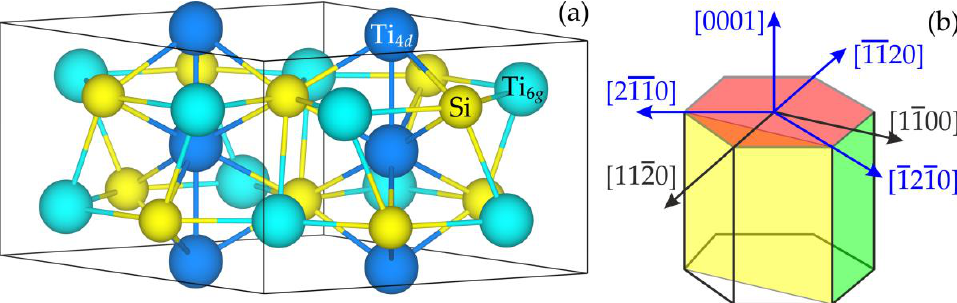
Figure 1. Atomic structure of bulk Ti 5 Si 3 ( a ) and denotation of low-index crystallographic planes in the hexagonal cell ( b ).